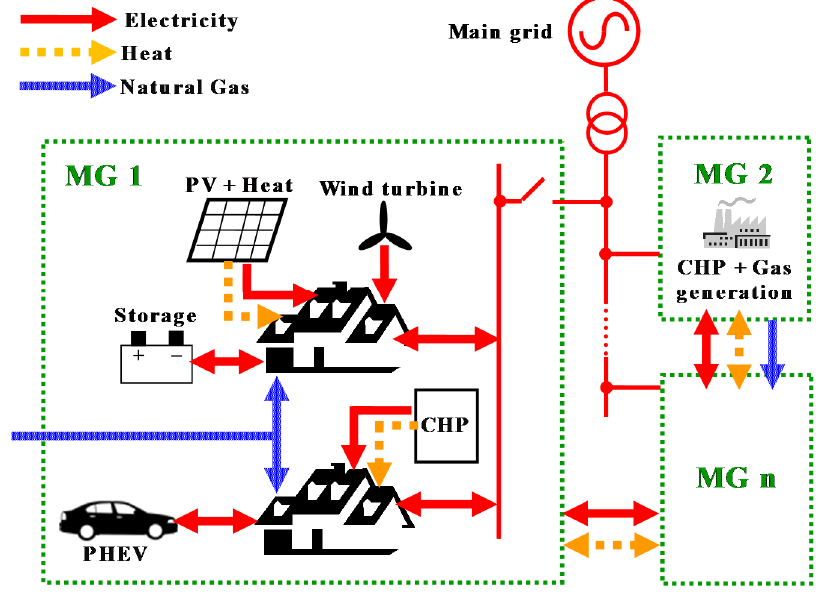
Figure 8. Structure of a “multi ‐ generation” MG scenario.